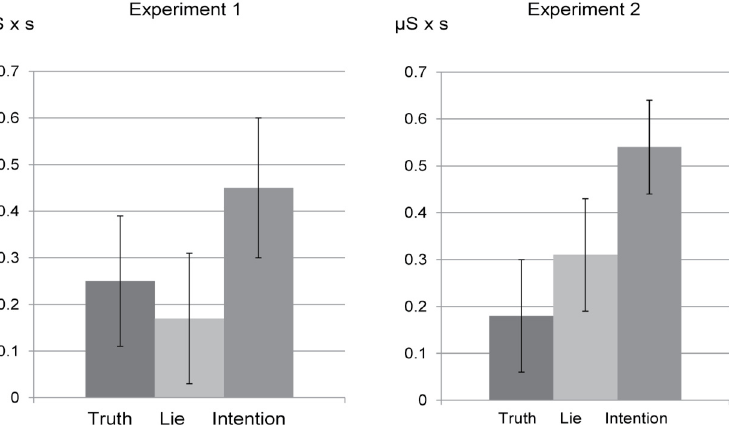
intention condition were 0.18 (0.12), 0.31 (0.12), 0.54 (0.10)